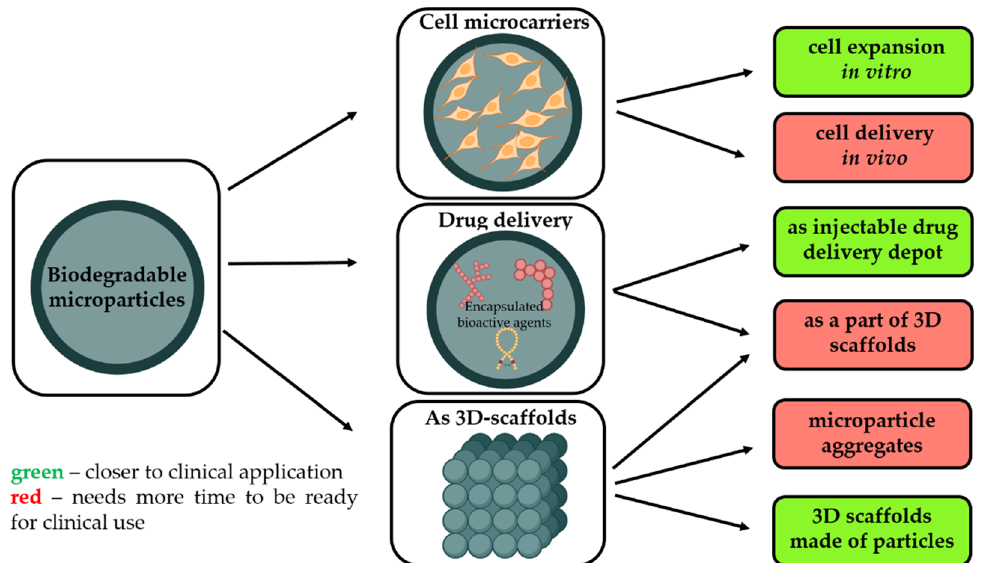
Figure 1. Different strategies of microparticles usage for regenerative medicine and perspective of their clinical application. Created by BioRender.com (accessed on 25 January 2022).